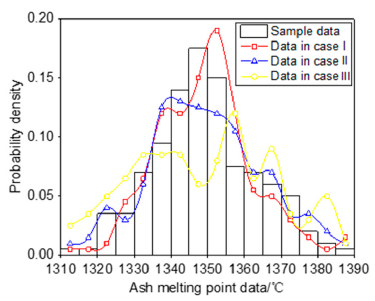
Figure 6. Comparison of probability density of the simulated and original AMP series in three cases.